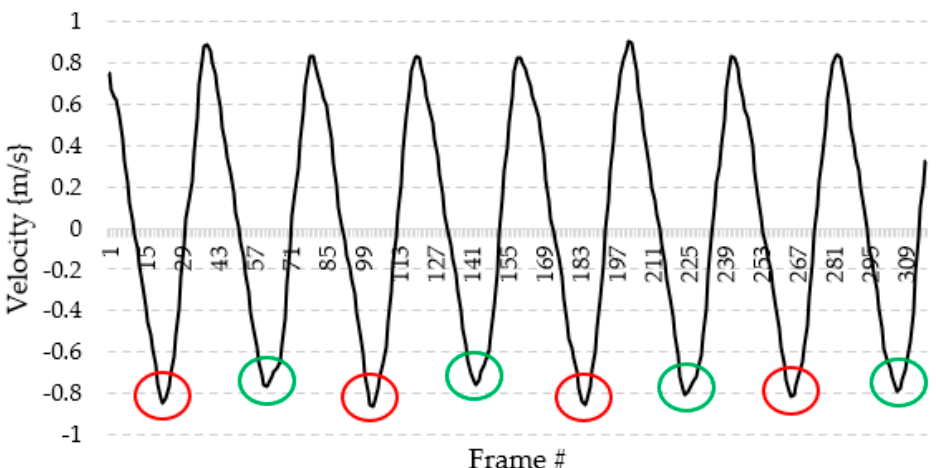
Figure 3. The foot strike gait event was determined for each footfall utilizing the vertical velocity of the whole-body center of mass. The data frame preceding the local minima (red and green circles) was tagged as foot strike alternating between left and right. The local minima represent the transition from downward trajectory of the COM to upward